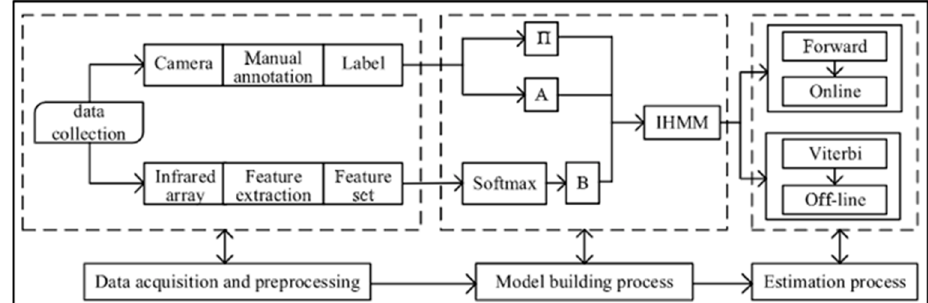
Figure 5. Raw data is obtained through infrared array sensors along with a camera to build occupancy transition probability matrix A. The parameter learning process of the IHMM model is introduced and the emission probability matrix B is calculated by Softmax Regression Model. Finally, according to the constructed IHMM, the Forward Algorithm and the Viterbi Algorithm are used to realize the online estimation and offline estimation of the indoor occupancy of a